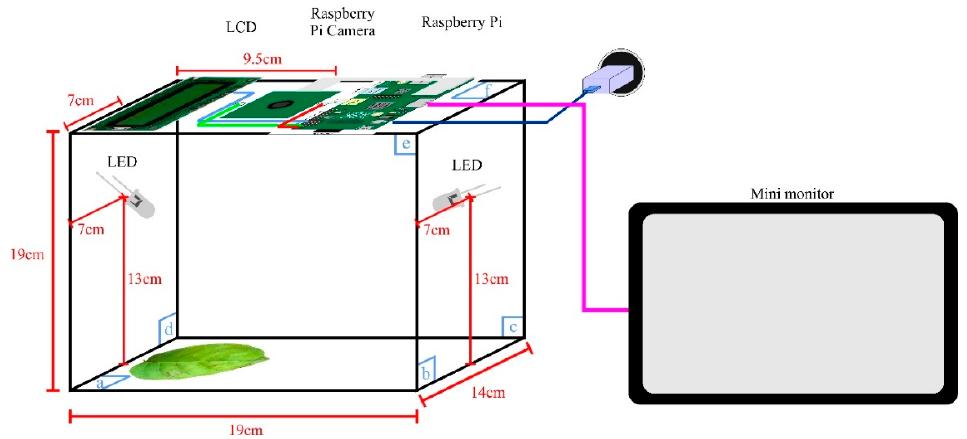
Figure 2. System hardware design.